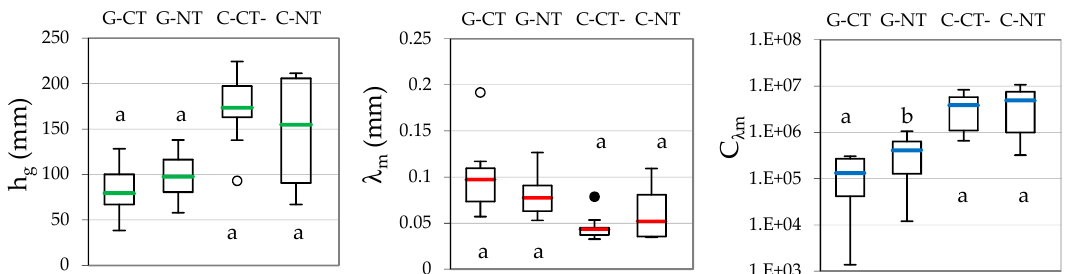
Figure 4. Mean values and interquartile range (min, max, 1st and 3rd quartile) of retention curve scale parameter, h g (in absolute value), flow-weighted mean pore size, λ m , and number of hydraulically active pores per unit area ( C λ m ) obtained with BEST-steady. Open circles represent outliers (closed circles extreme outliers). For a given site, Gravina and Candela (G and C), soil management strategies (CT or NT) followed by the same letter are not significantly different according to a two-tailed t -test ( p = 0.05). Water 2018 , 10 , x FOR PEER REVIEW